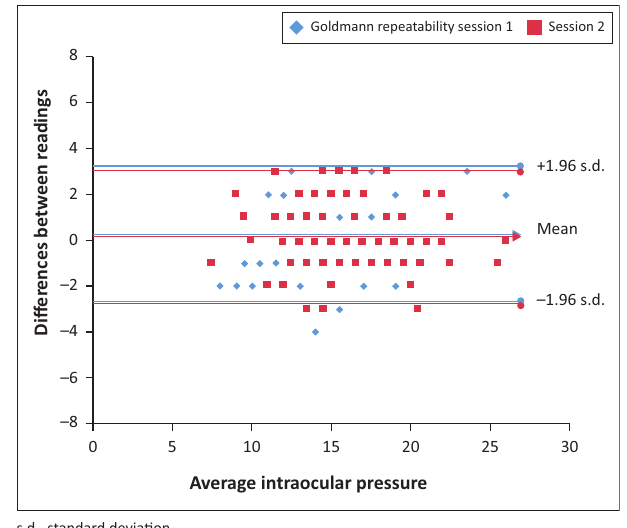
FIGURE 1: Limits of within-session repeatability for Goldmann applanation tonometer intraocular pressure measurements in mmHg.